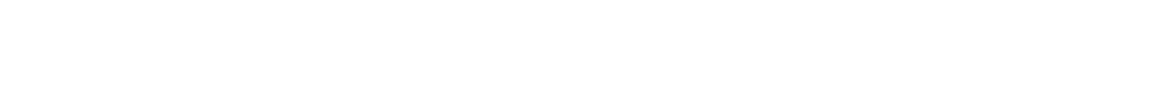
FIGURE9| Electronicbandstructureanddensitiesofstatesof:ZnS(220):V S (A) ,ZnS(220):V Zn (B) ,ZnS(220)+NaBH 4 (C) ,ZnS(220):V S +NaBH 4 (D) .Thedashed lines indicate the highest occupied state.